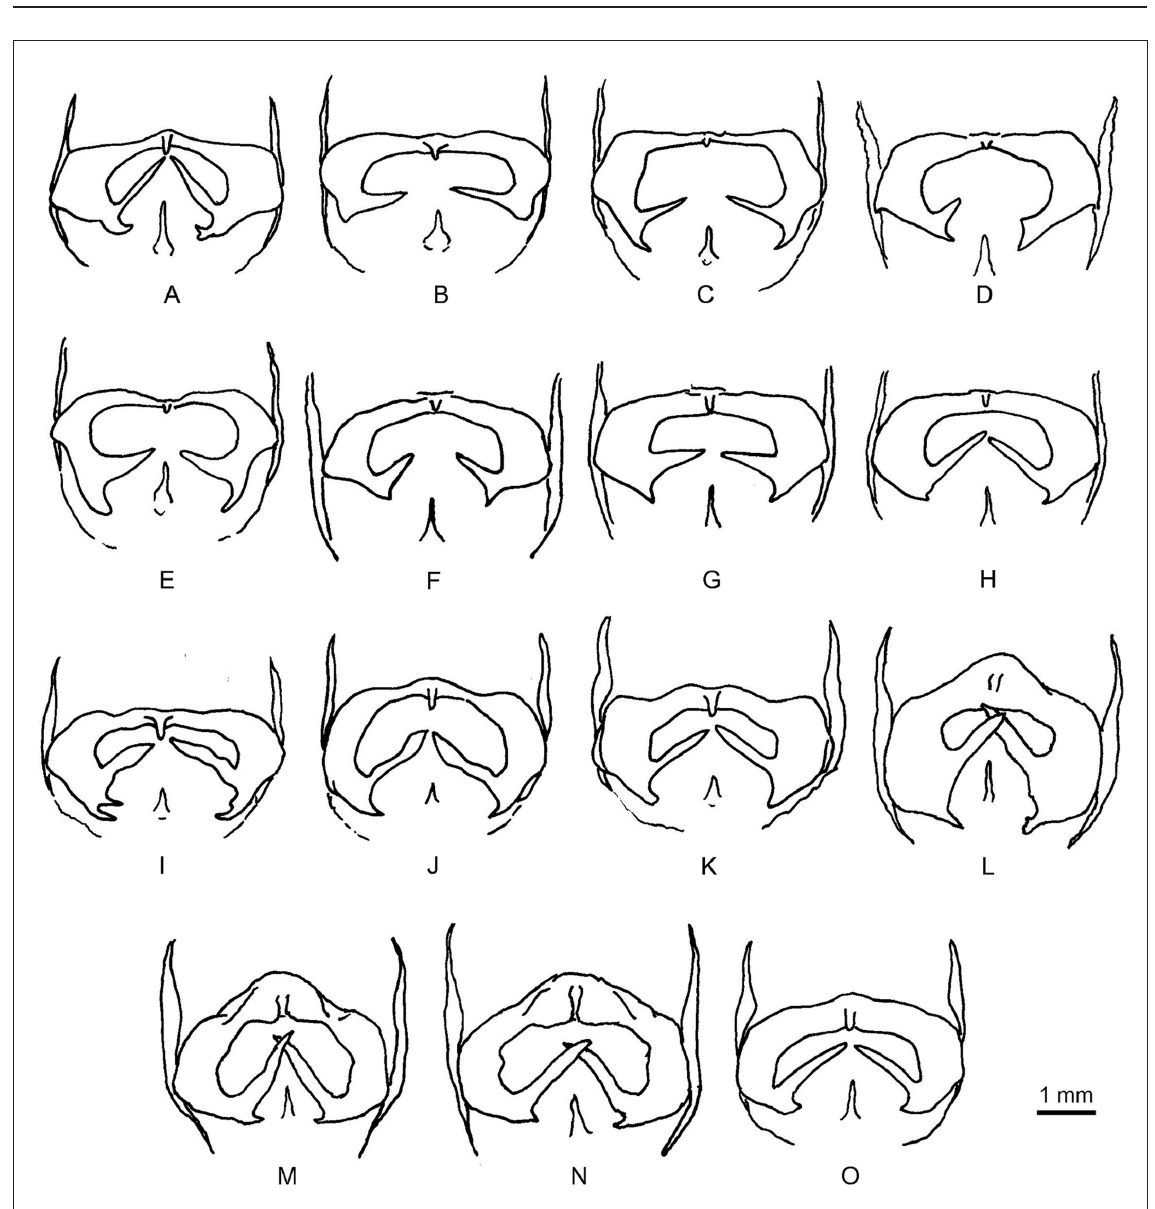
Fig. 15. Female sterigma. A . Eryphanis zolvizora zolvizora (Hewitson, 1877) (Bolivia; MNHN, CG). B-H . Eryphanis zolvizora chachapoya ssp. nov. B . PT from Cushi, Pasco, Peru (BMNH 8226). C . PT from Carpish, Huánuco, Peru (MNHN, PBB 2285). D . Specimen from Mallqui, Huánuco, Peru (MNHN, PBB 2327). E . PT from San José de Molinopampa, Amazonas, Peru (MNHN, PBGL 198). F . PT from Nieva, Amazonas, Peru (MNHN, PBGL 596). G . PT from Alto Nieva, Amazonas, Peru (MNHN, PBGL 519). H . Specimen from Alto Nieva, Amazonas, Peru (MNHN, PBGL 520). I . Eryphanis zolvizora greeneyi Penz & DeVries, 2008, stat. rev., specimen fromValladolid, Zamora-Chinchipe, Ecuador (MNHN, PBB 2288). J . Eryphanis zolvizora casagrande ssp. nov., PT from La Planada,